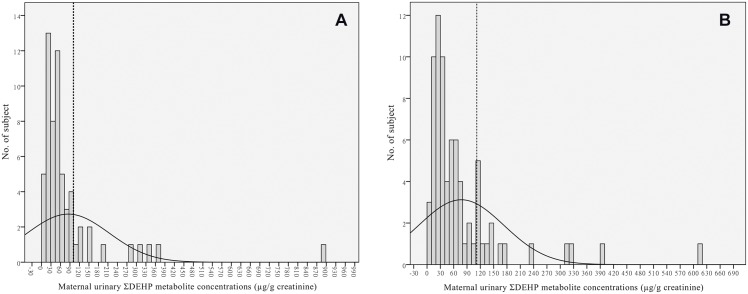
Distribution of urinary phthalate metabolite concentrations (μg/g creatinine) in pregnant women.The sum of di-2-ethylhexyl phthalate (ΣDEHP) metabolite concentrations was skewed to the right. Subjects in the highest quintile (80th to 100th percentile) showed the strongest determinant of the outcomes of interest. (A). The cut-point for the highest quintile of maternal ΣDEHP metabolite concentration was 101 μg ΣDEHP/g creatinine in boys. (B). The cutoff was 112 μg ΣDEHP/g creatinine in girls.